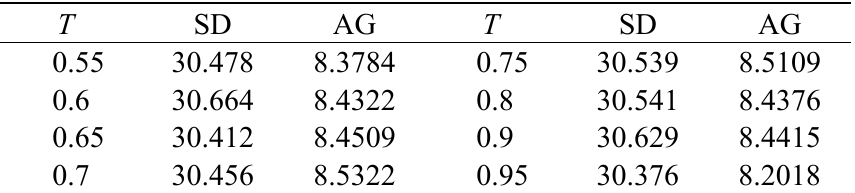
Table 1. The tradeoff selection for T